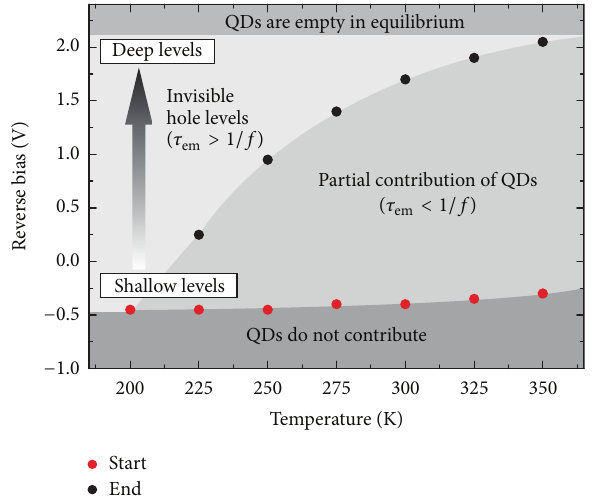
Figure 2: Bias voltages of the start and end of the plateau in Figure 1 as a function of temperature (derived from the maxima in the second derivative of the C-V curves; see inset of Figure 1). As the temperatureisincreased,moreandmoreholelevelsarecontributing to the total capacitance for a given measurement frequency (here 𝑓 = 1 MHz).